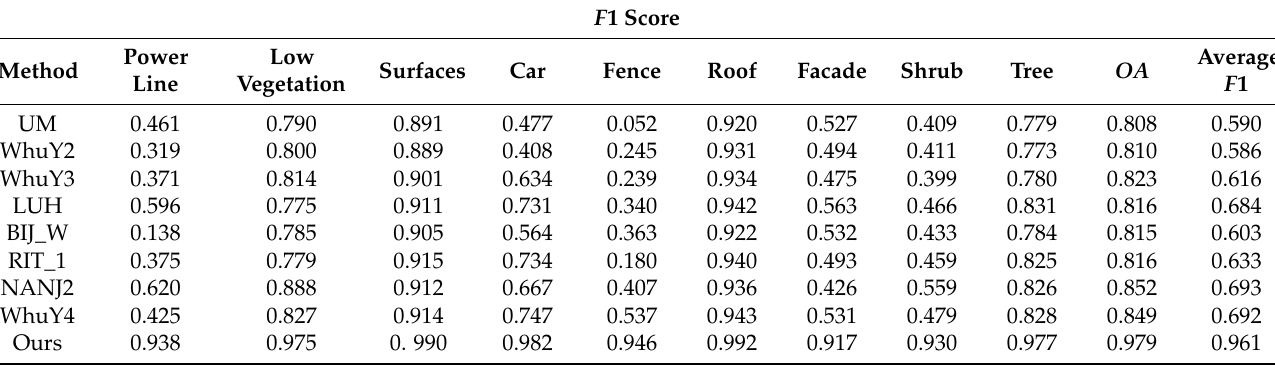
Figure 7. Classification results of the Vaihingen urban 3D semantic dataset obtained by different algorithms, where the black circle highlights the differences among ( a – c ). ( a ) Baseline; ( b ) Ours; ( c ) Ground truth. Table 2. Comparison of the proposed method in this paper with the results provided by the ISPR